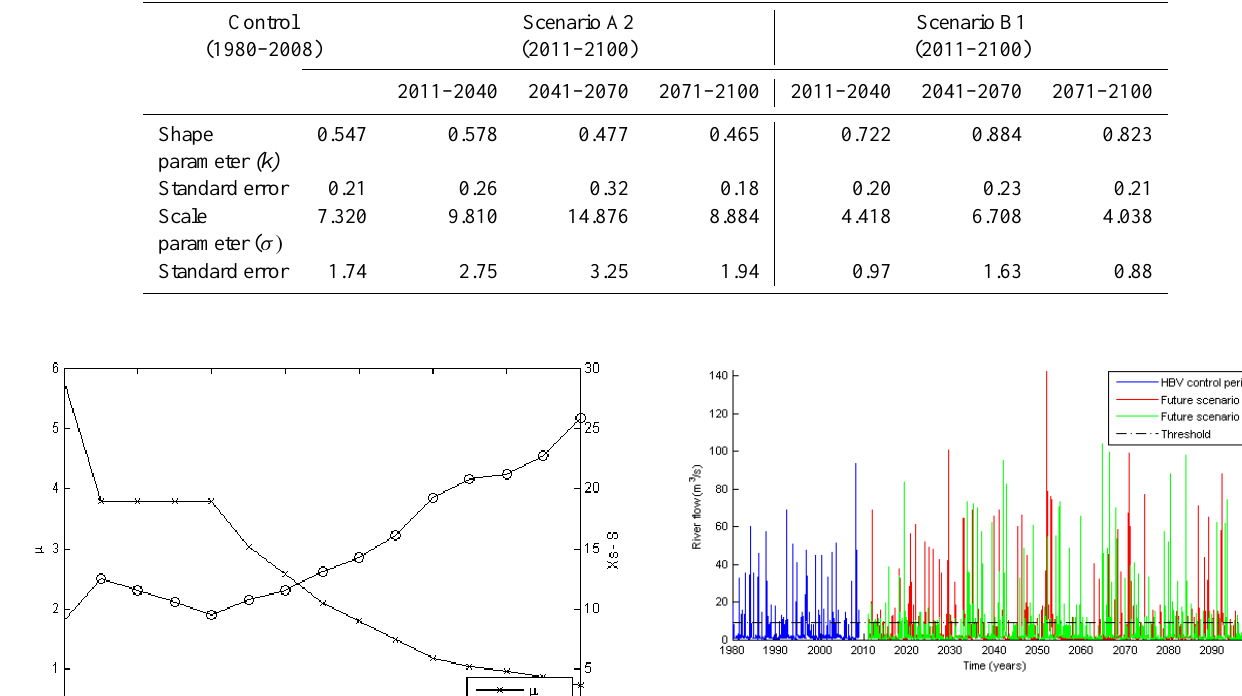
Figure 9 Time series of the discharge values in the Anoia sub-basin. The HBV simulations for 2 Fig. 9. Time series of the discharge values in the Anoia sub-basin. the control (1980-2008) period (blue) is plotted. The future (2011-2100) discharge series 3 The HBV simulations for the control (1980–2008) period (blue) is computed with the HBV model for the A2 (red) and B1 (green) SRES scenarios are also 4 plotted. The future (2011–2100) discharge series computed with the presented. The dashed black line represents the threshold of 9 m 3 ·s -1 . 5 HBV model for the A2 (red) and B1 (green) SRES scenarios are also presented. The dashed black line represents the threshold of 9m 3 s − 1